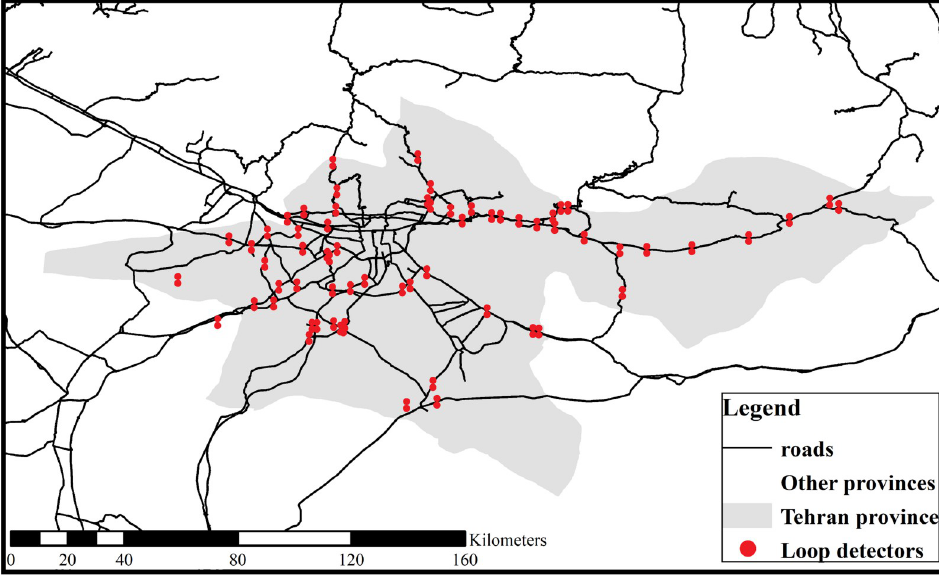
Fig 2. Map of rural highways and loop detectors in Tehran province. Reprinted from [54] under a CC BY license, with permission from the Iran Ministry of Roads and Urban Development (MRUD), original copyright 2023.